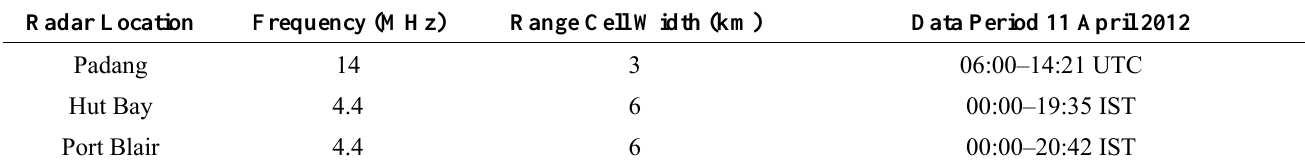
Table 1. Radar parameters and data